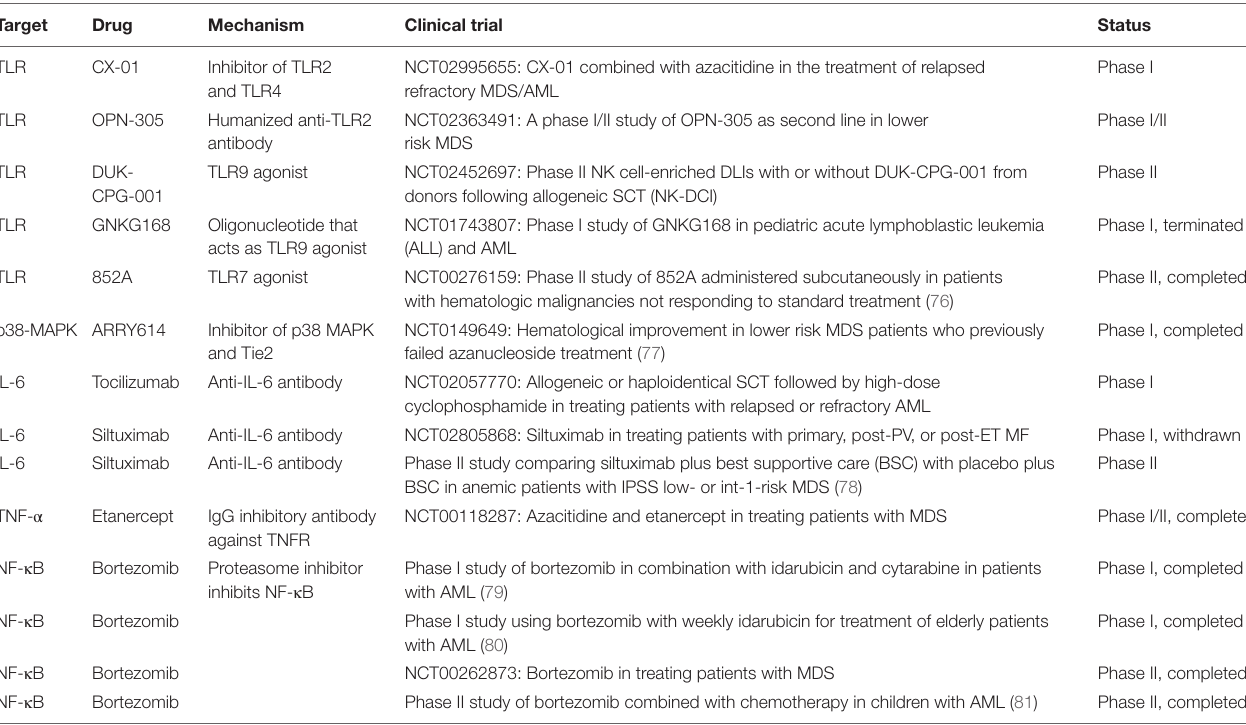
TABLe 2 | Clinical trials targeting inflammatory signaling pathways in MDS, MPN, and